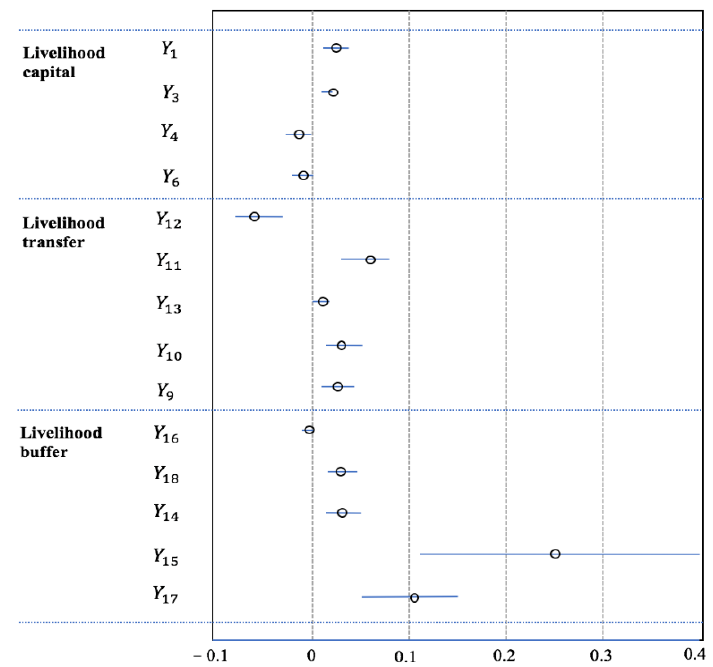
Figure 6. Coe ffi cient plot of factors influencing livelihood resilience. Source: designed by the authors. Note: Dots represent standardised beta coe ffi cients; 95% confidence intervals are represented as whiskers. 451 Table 4. Statistical results of multiple linear regressions on RAFs’ livelihood resilience. 452